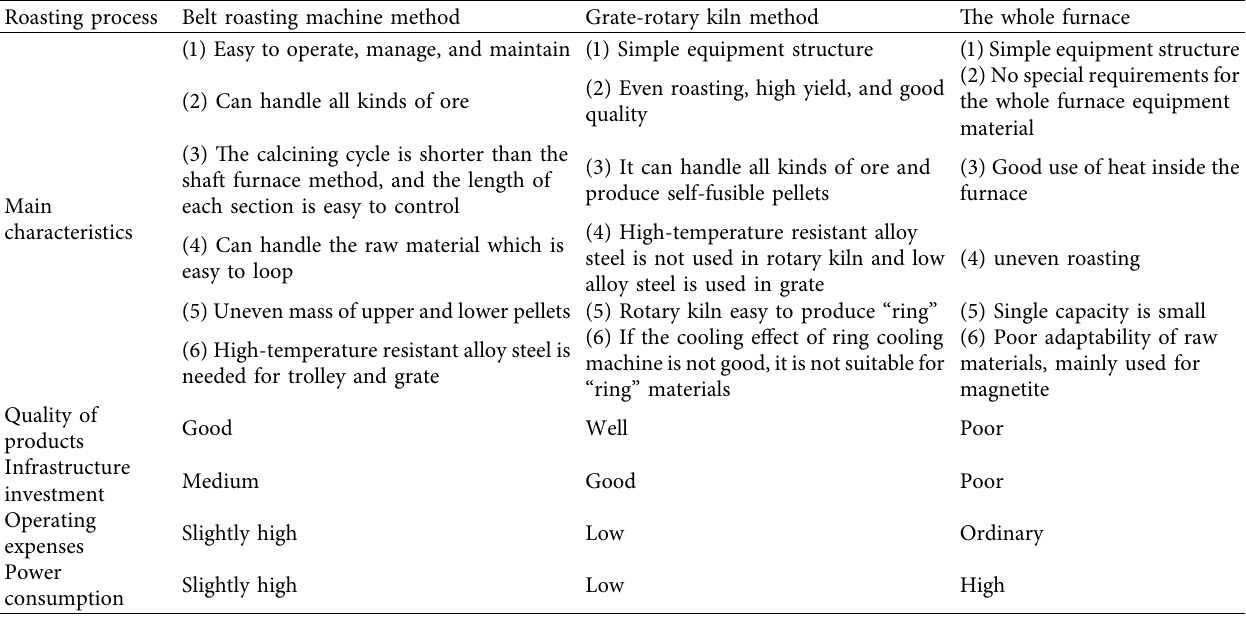
Table 1: Comparison of three pelletizing methods.